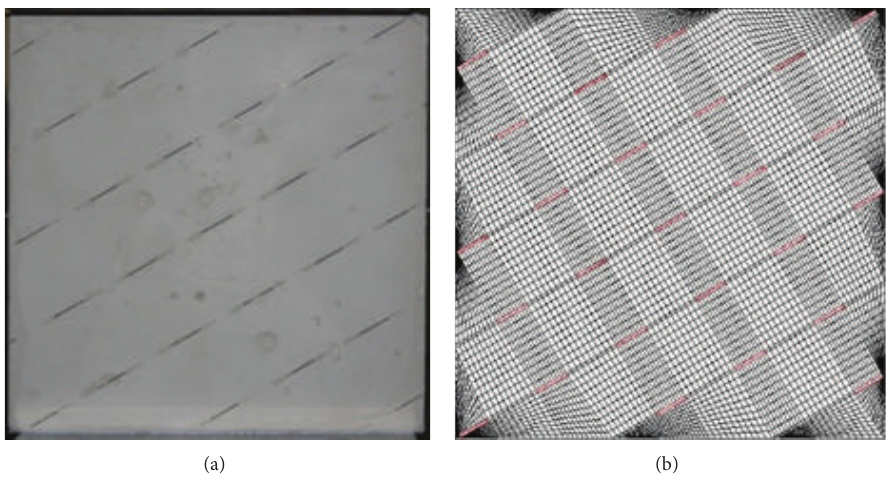
Figure 4: The precrack specimen and numerical model.